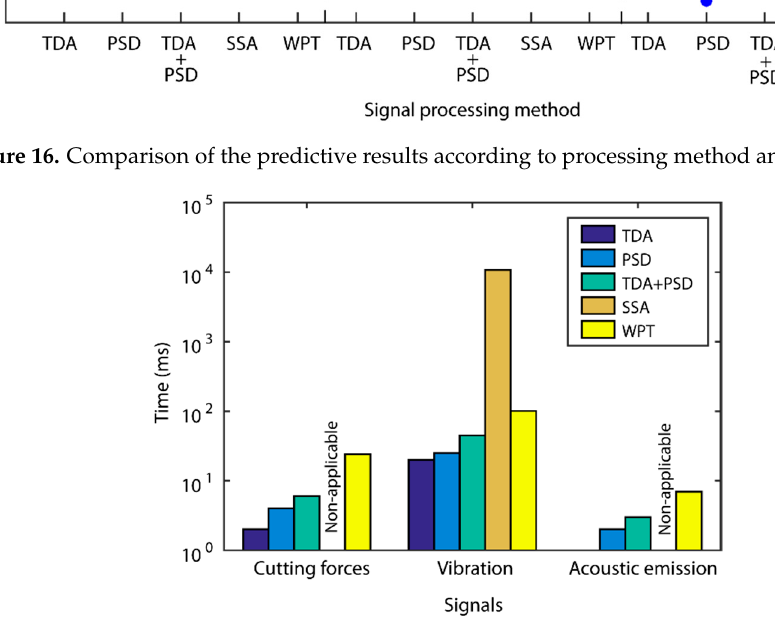
Figure 17. Response times obtained for the TDA, PSD, TDA + PSD, SSA, and WPT processing methods.